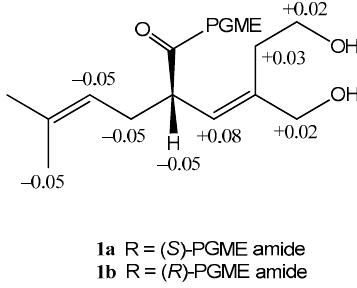
Figure 5. 1 H chemical-shift differences ( Δ δ ppm) between the ( S )- and ( R )- PGME amides 1a and 1b .